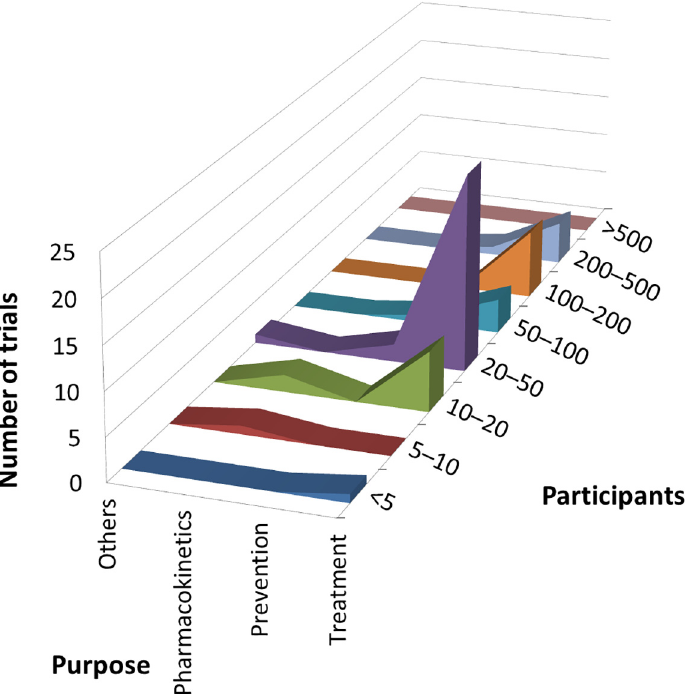
Fig 6. Cross-analyses between trial purpose and participants in Japanese registries. Curve areas represent the number of trials across participants and the trial purposes.